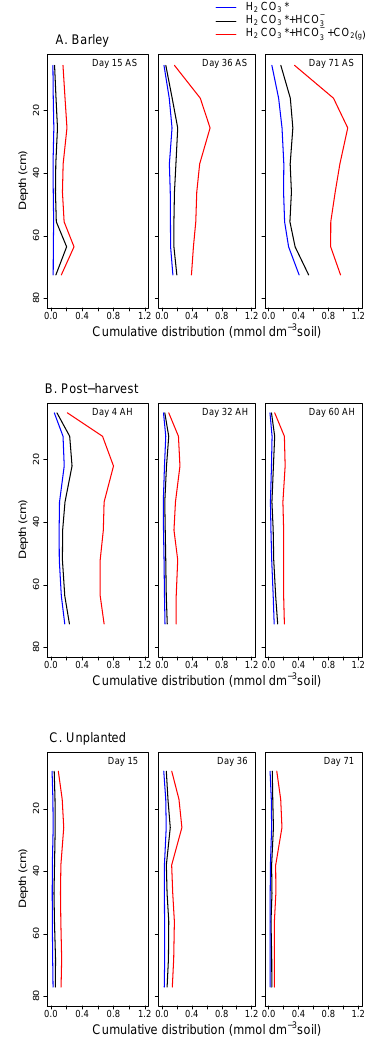
Figure 2. Distribution of inorganic carbon between dissolved inor- ganic carbon (DIC) species and CO 2 ( g ) at the start (day 15 in (a) and (c) , day 4 in (b) ), in the middle (day 36 in (a) and (c) , day 32 in (b) ) and at the end (day 71 in (a) and (c) , day 60 in (b) ), of experiments in mesocosms with barley (a) , post-harvest (b) and in unplanted mesocosms (c) . Shown are the means for each treatment. AS represents after sowing, AH represents after harvest. The con- centration of carbonate was negligible compared to the other species and is not